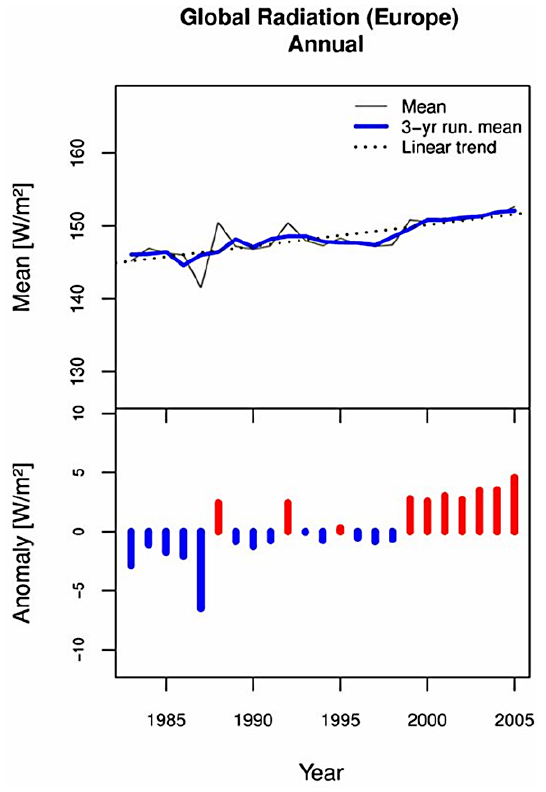
Figure 6. Time series of average annual global radiation for Europe (top) and time series of anomalies (bottom) based on the CM SAF MVIRI data set.